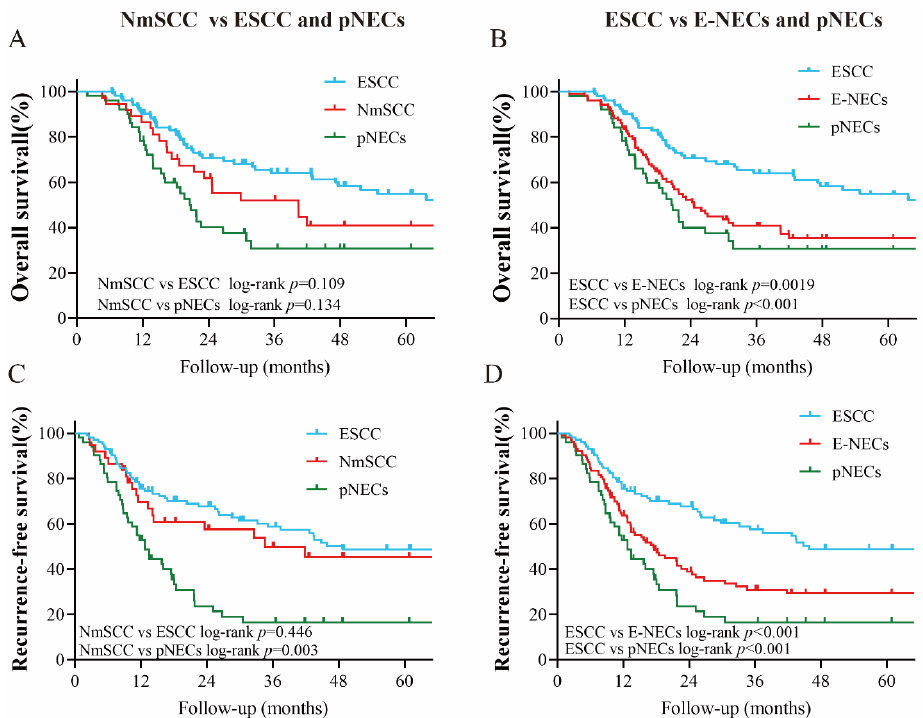
Figure 5. Comparisons of OS and RFS between subgroups of E-NECs with different components: ( A , C ) NmSCC vs. ESCC and pNECs; ( B , D ) ESCC vs. E-NECs and pNECs. Abbreviations: ESCC, esophageal squamous cell carcinoma; E-NECs, esophageal neuroendocrine carcinomas; pNECs, pure neuroendocrine carcinomas; NmSCC, neuroendocrine neoplasms mixed with squamous cell carcinoma.